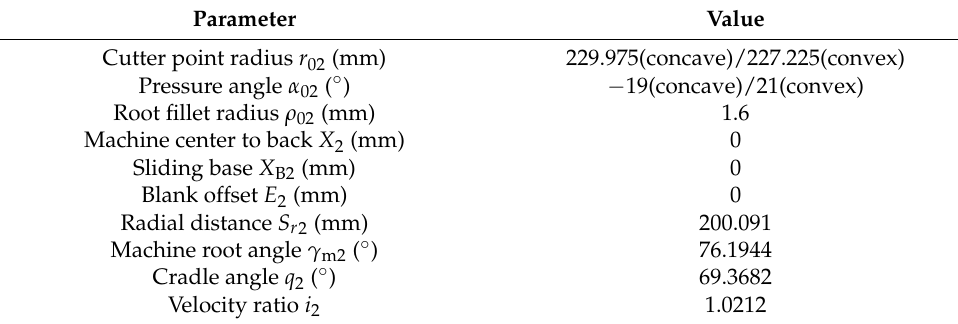
Table 3. Machine tool settings of bevel gear.